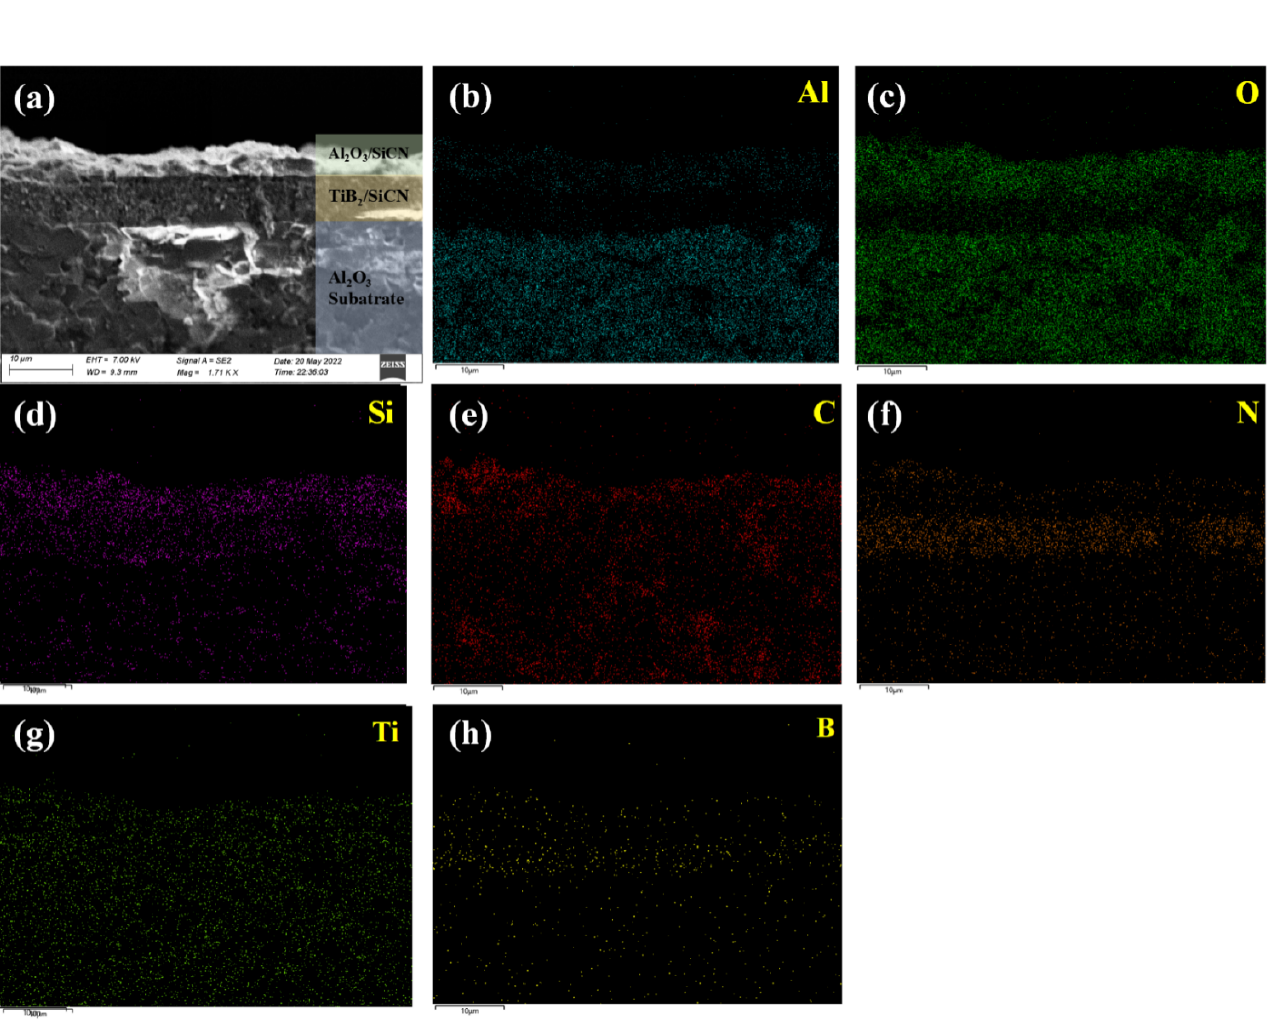
Figure 4. The cross-sectional SEM-EDS images of Al 2 O 3 /SiCN-TiB 2 /SiCN film on Al 2 O 3 substrate af- ter oxidation at 1000 °C for 1 h: ( a ) SEM, ( b ) Al element map, ( c ) O element map, ( d ) Si element map, ( e ) C element map, ( f ) N element map, ( g ) Ti element map, and ( h ) B element map.